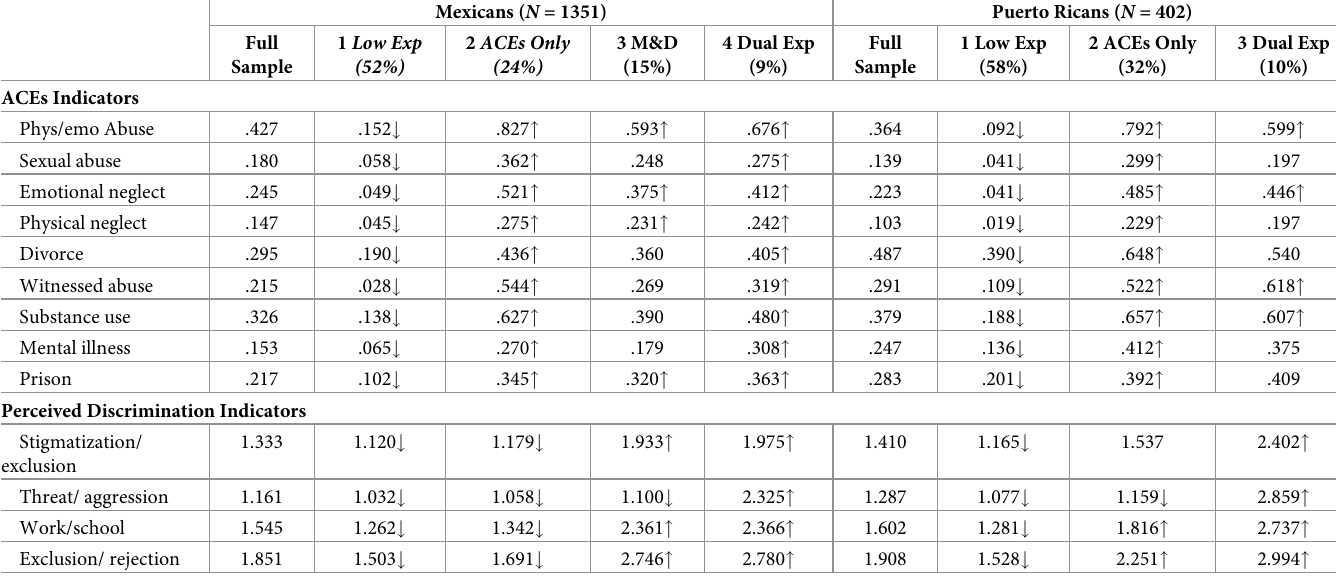
Table 5. Item response probabilities for Mexicans and Puerto